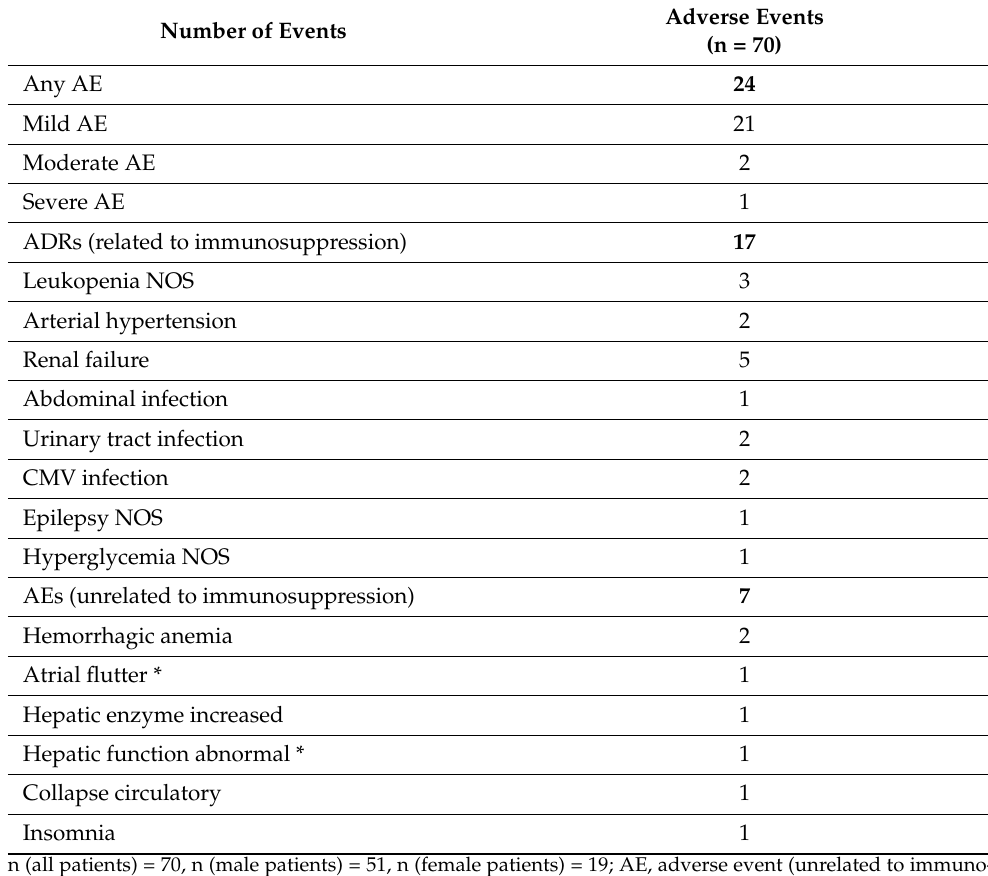
Table 2. Safety events by MedDRA